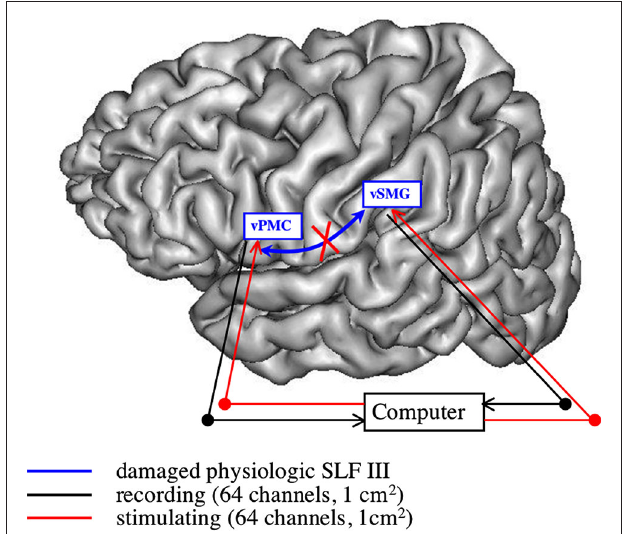
FIGURE 1 | Restoring the articulatory loop following white matter damage . This subnetwork is constituted by the ventral premotor cortex (vPMC) (BA 6) and the (antero-)ventral supramarginal gyrus (vSMG), linked through the third branch of the superior longitudinal fasciculus (SLF III). When this pathway is damaged, with cortical areas still intact, one has to recreate a bidirectional synchronized link: stimulation pattern over one area is computed from the recorded activity in the other area, introducing a time lag (see for example Jackson et al., 2006 for a short-range unidirectional version of such